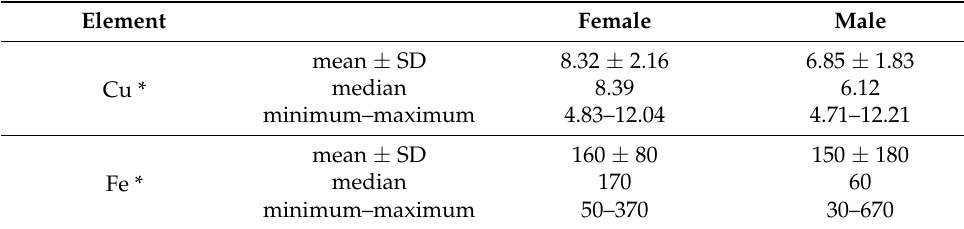
Table 7. Differences detected between sexes (mg · kg − 1